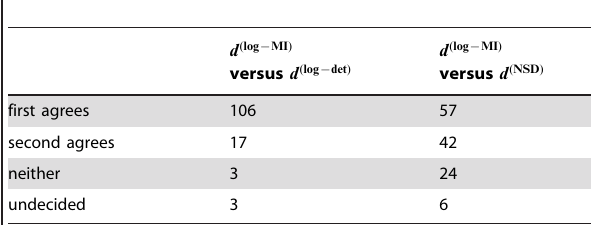
Table 1. Number of quartets for which each pairwise metric produces a topology that agrees better with that found in the